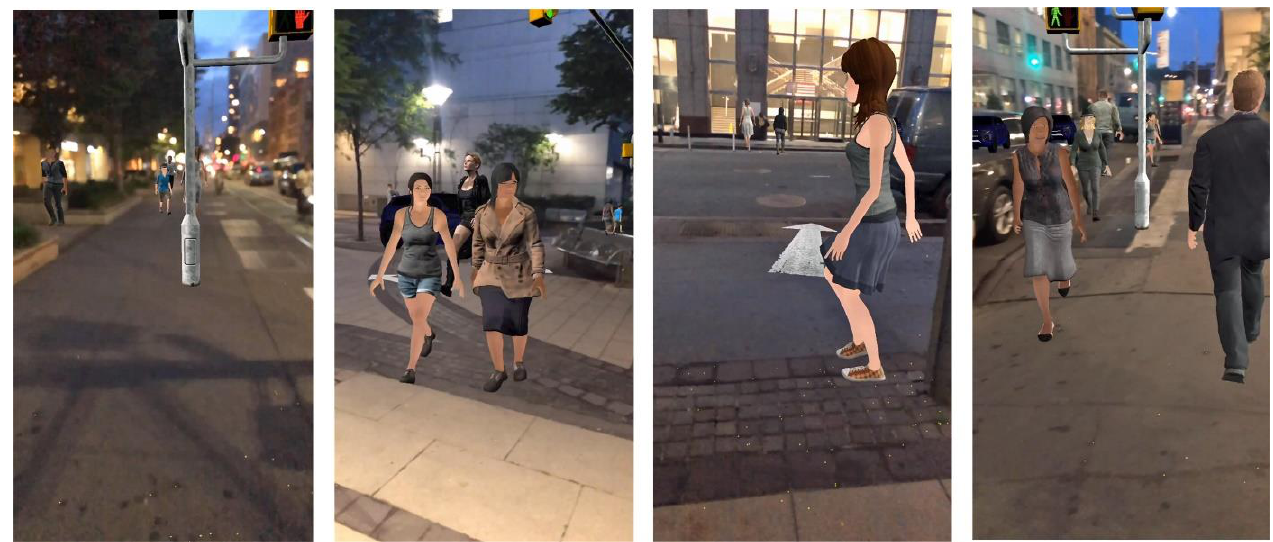
Figure 10. Four screenshots from our smart phone augmented reality system for populating real retail high streets with synthetic, agent-based pedestrians and shoppers [287].